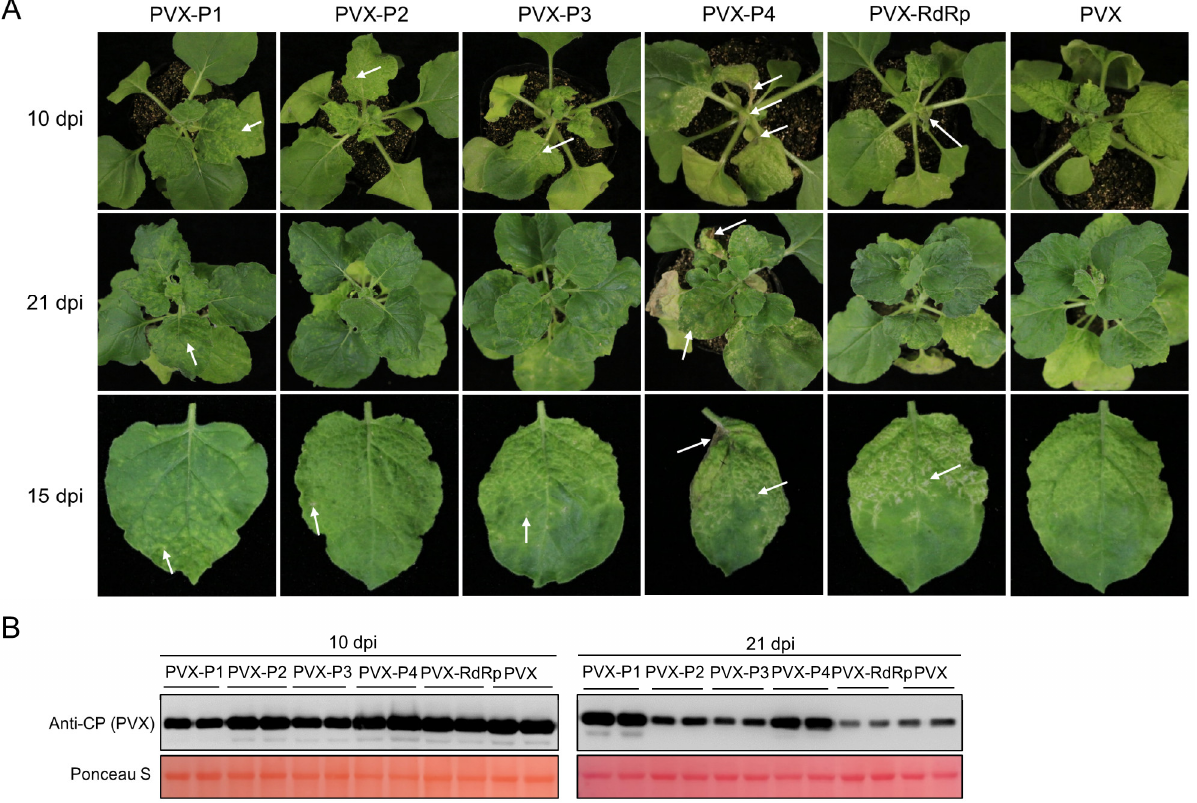
Figure 6. Symptom determinant analysis of PSCYV using the PVX heterologous expression system. ( A ) Symptoms of N. benthamiana plants expressing PSCYV P1, P2, P3, P4, or RdRp using the PVX expression vector. White arrows indicate necrotic sites. ( B ) Western blot assay analyses of PVX CP accumulation levels in infected N. benthamiana plant leaves at 10 dpi and 21 dpi. The large RuBisCO subunit stained by Ponceau S serves as the loading control.